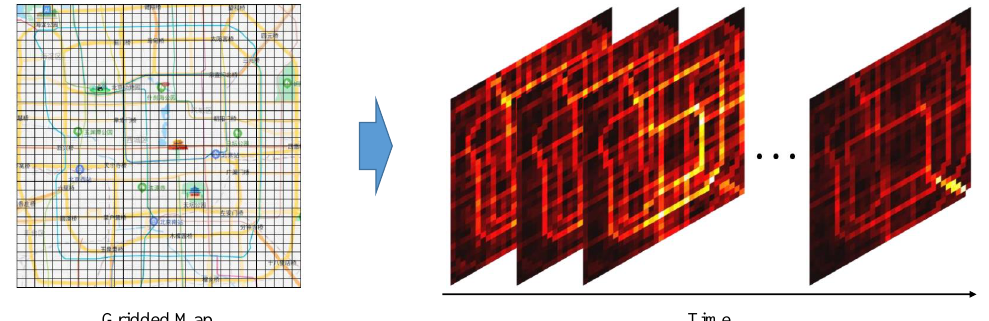
Figure 1. The grid-format traffic forecasting problem [22,23].